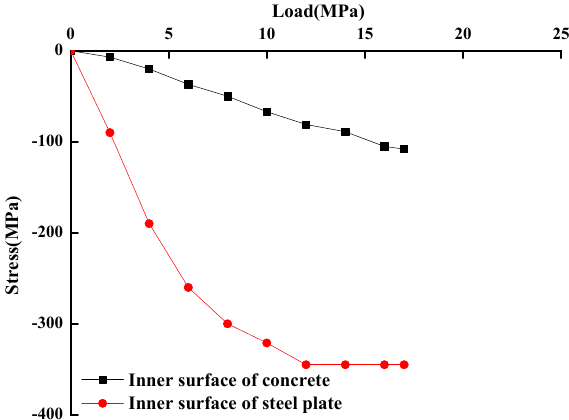
Figure 11. Load–hoop stress curve of specimen ZJ6. Figure 12. Load–hoop stress curve of specimen ZJ8. Figure 9. Load–hoop stress curve of specimen ZJ1. Figure 10. Load–hoop stress curve of specimen ZJ4. Figure 10. Load–hoop stress curve of specimen